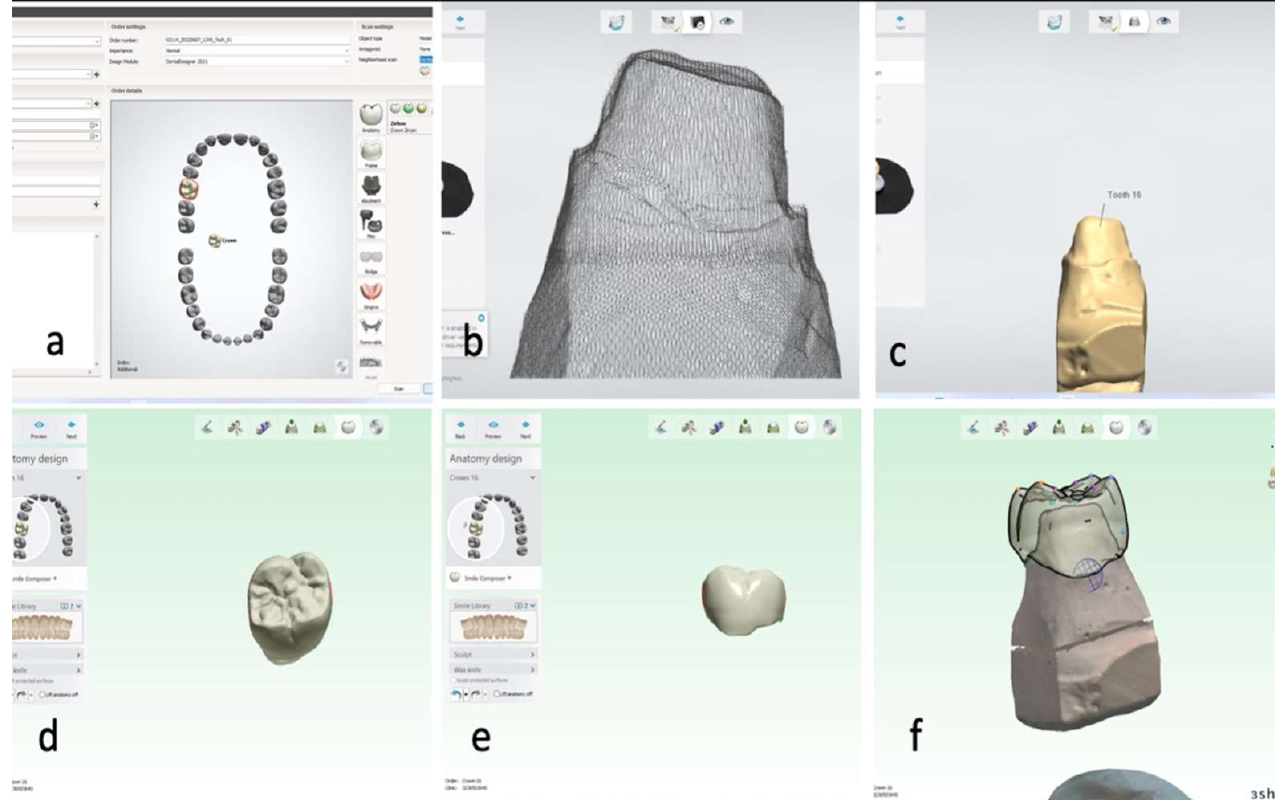
Figure 2. Representative images showing CAD process of metal crown fabrication. ( a ) Selection of tooth to be fabricated in 3-shape CAD software; ( b ) initial scanning process of mesh formation of sample by desktop scanner (Ceramill Map 400; AmannGirrbach); ( c ) final scanned image of the sample in 3-shape CAD software; ( d ) occlusal view of the designed crown; ( e ) buccal view of the designed crown; and ( f ) designed crown over the die, finalized by the 3-shape CAD software. The artificial crowns were then cemented in 4 groups (CGr) as described previously.